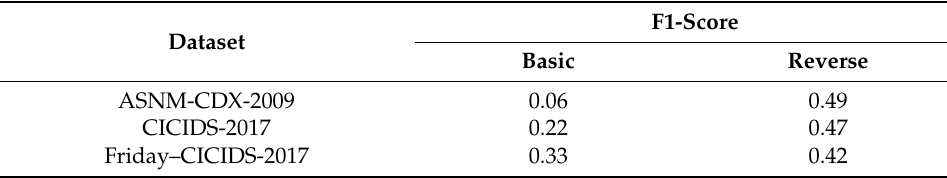
Table 7. Isolation Forest algorithm results comparison for all datasets.